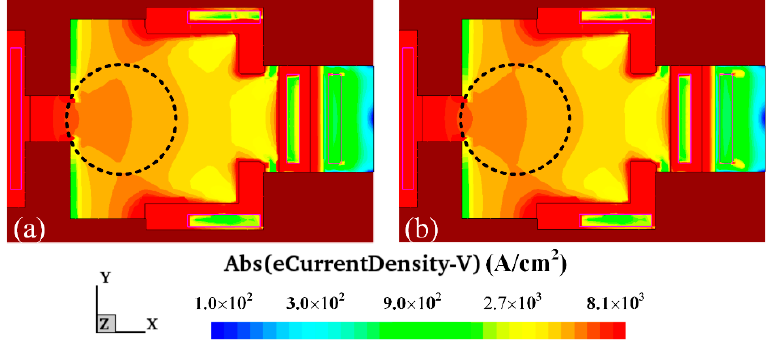
Figure 4. Carrier density distribution of the MMF sensor under the y ‐ direction magnetic field.